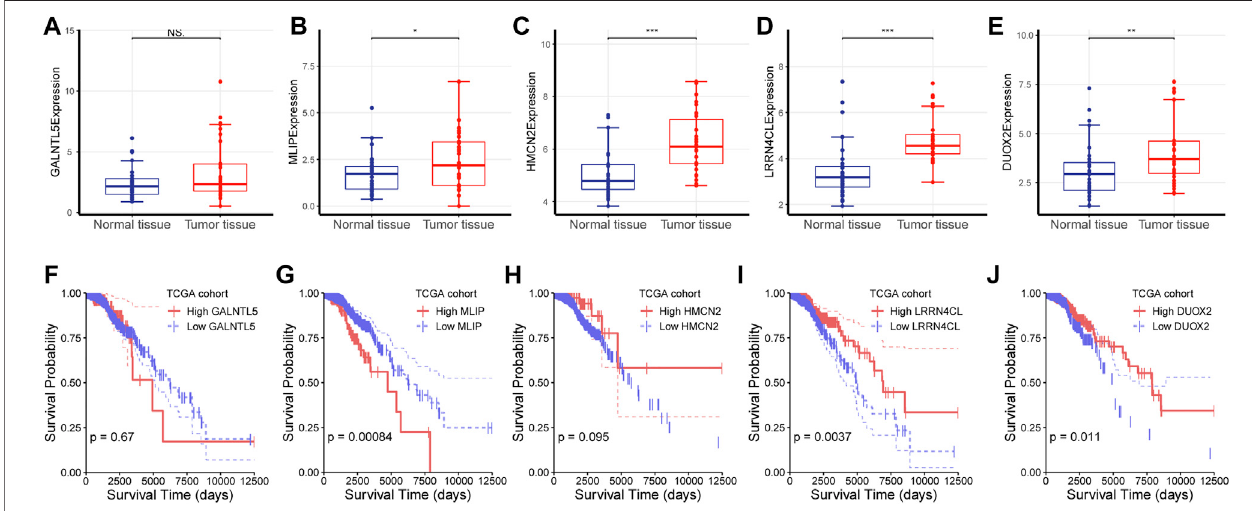
FIGURE5| Investigationontheroleofthe fi vecytotoxicity-associatedkeygenes (A – E) Theexpressionofeachgenewascharacterizedbetweennormaltissueand tumor tissue. NS: No signi fi cance, p : p < 0.05, pp : p < 0.05, ppp : p < 0.001.